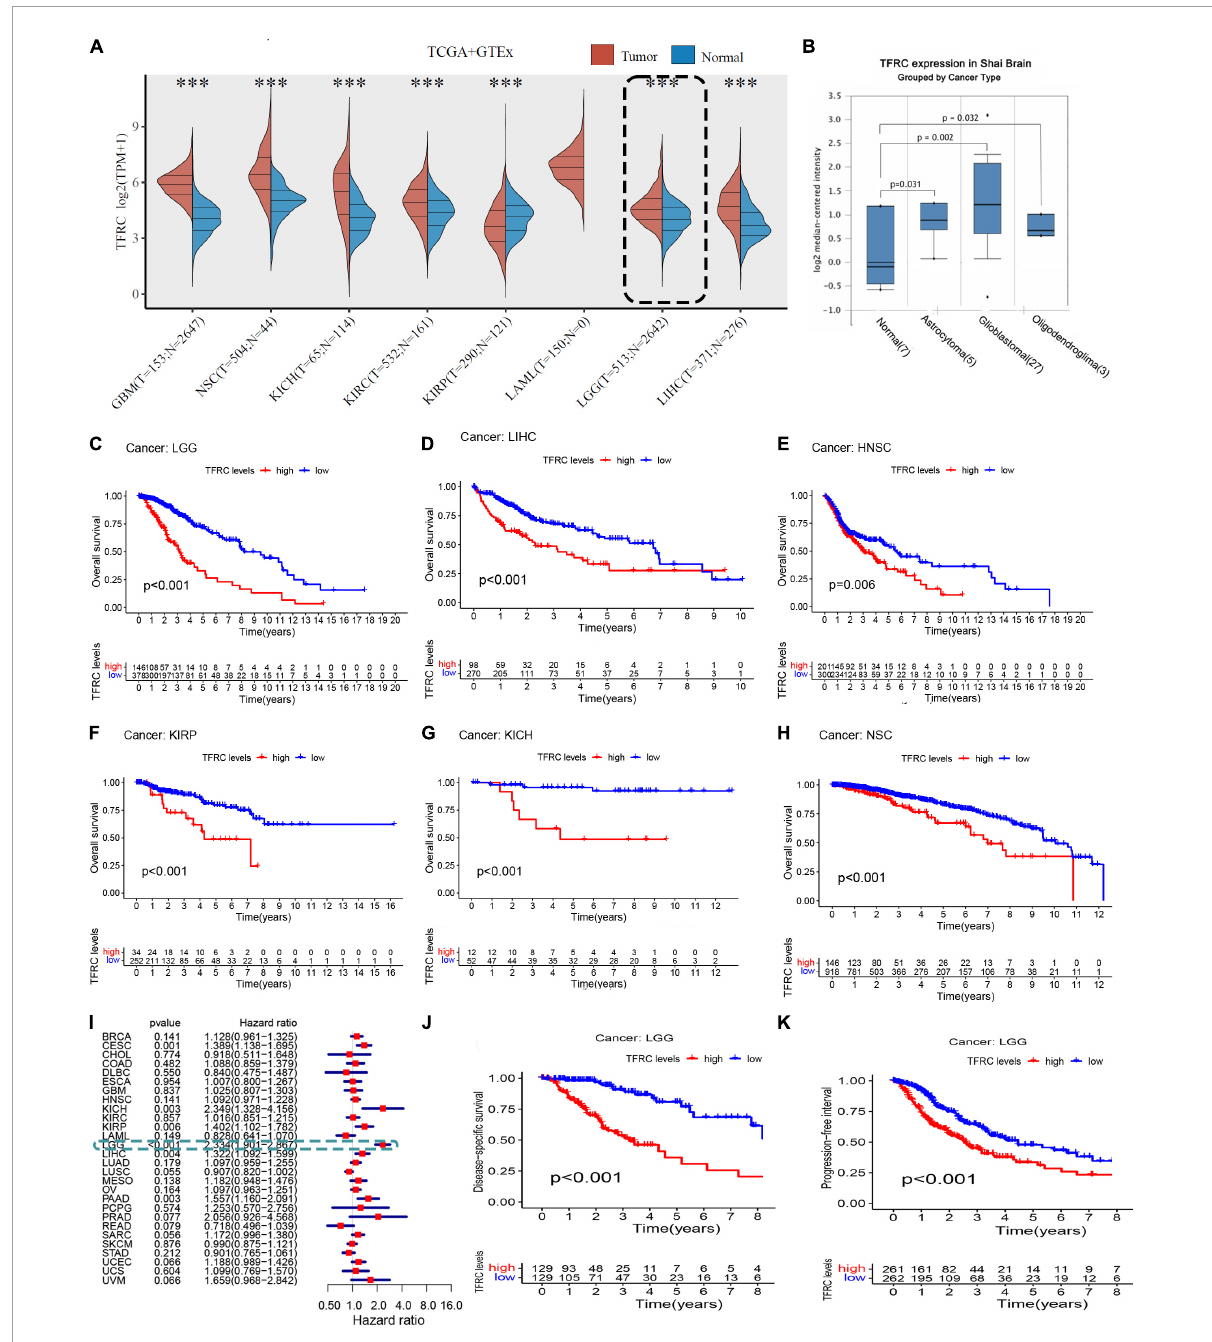
FIGURE1 Association of TFRC expression level and survival in LGG. (A) TFRC mRNA expression in TCGA LGG tissues and GTEx adjacent normal tissues. (B) TFRC expression in GEO. (C–H) TFRC expression effect on OS in TCGA tumor patients by Kaplan–Meier survival analysis. (I) Forest plot showing TFRC expression effect on OS in TCGA tumor patients by Cox regression. Association of TFRC expression level and survival in LGG. (J) TFRC mRNA expression correlation with DSS. (K) TFRC mRNA expression correlation with PFI. *** p < 0.001.